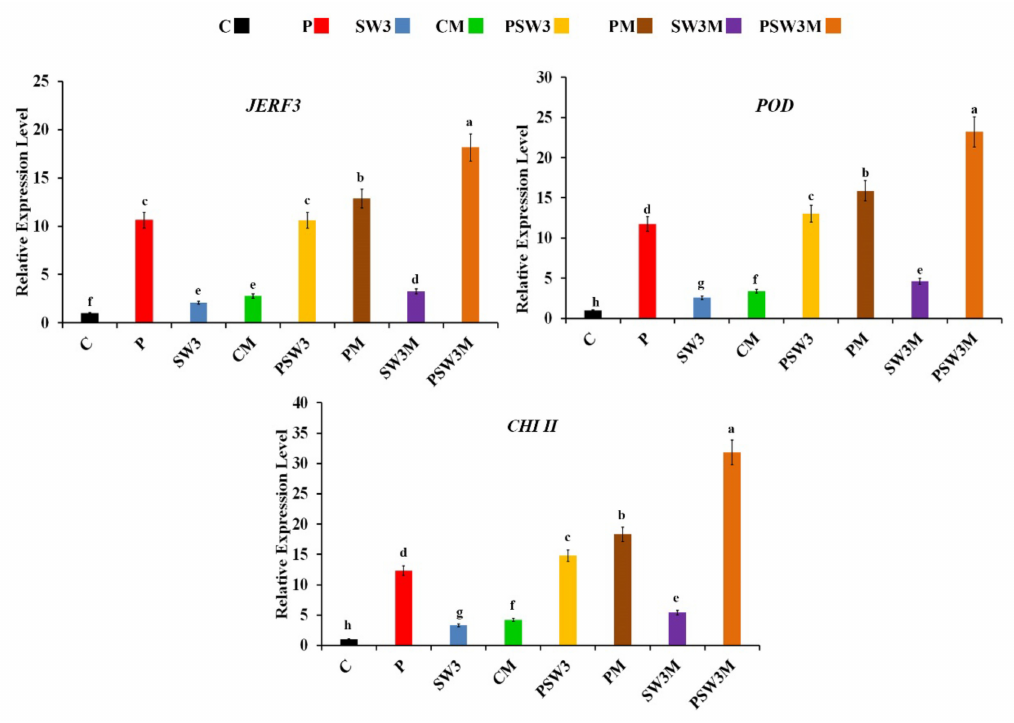
Figure 1. Histograms showing the relative transcriptional expression levels of the jasmonate and ethylene-responsive factor 3 ( JERF3 ) and two defense-related genes; peroxidase ( POD ) and chitinase II ( CHI II ) in roots of pea infected with Rhizoctonia root rot in response to treating with the seaweed extract at 3% and/or colonization with arbuscular mycorrhizal fungi, seven days post-pathogen inoculation. Where, C: non-treated control, CM: uninfected and mycorrhizal, P: infected and non- mycorrhizal, PM: infected and mycorrhizal, SW3: uninfected, non-mycorrhizal, and treated with the seaweed extract at 3%, SW3M: uninfected, mycorrhizal, and treated with the seaweed extract at 3%, PSW3: infected, non-mycorrhizal, and treated with the seaweed extract at 3%, and PSW3M: infected, mycorrhizal, and treated with the seaweed extract at 3%. For each gene, columns superscripted with the same letter are not significantly different according to Tukey’s HSD test at p ≤ 0.05. Each value represents the mean of three biological replicates; each sample was analyzed in triplicate. Error bars represent standard